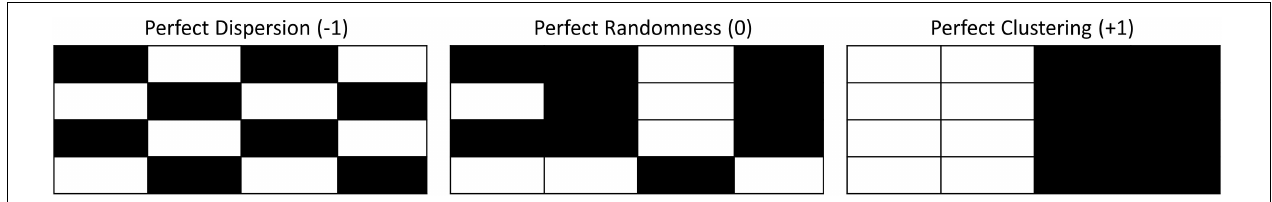
FIGURE 3 | From Kates Varghese et al. (in review). Spatial configurations that would result in ideal Moran’s I values: left – perfect dispersion, Moran’s I value = − 1; middle – perfect randomness, Moran’s I value = 0; right – perfect clustering, Moran’s I value = +1.